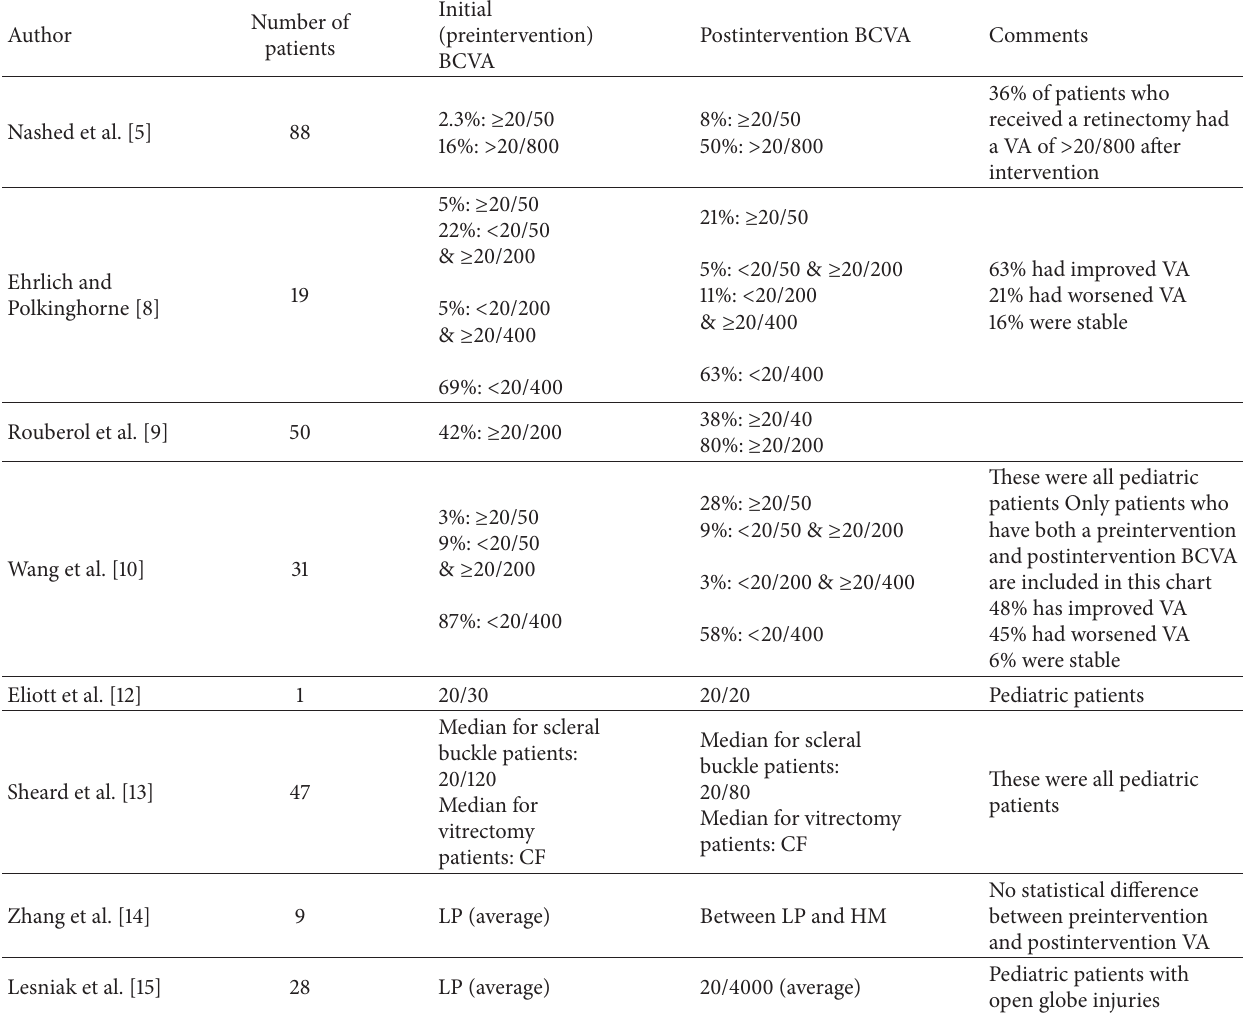
Table 3: Visual Acuity after Traumatic Retinal Detachment.